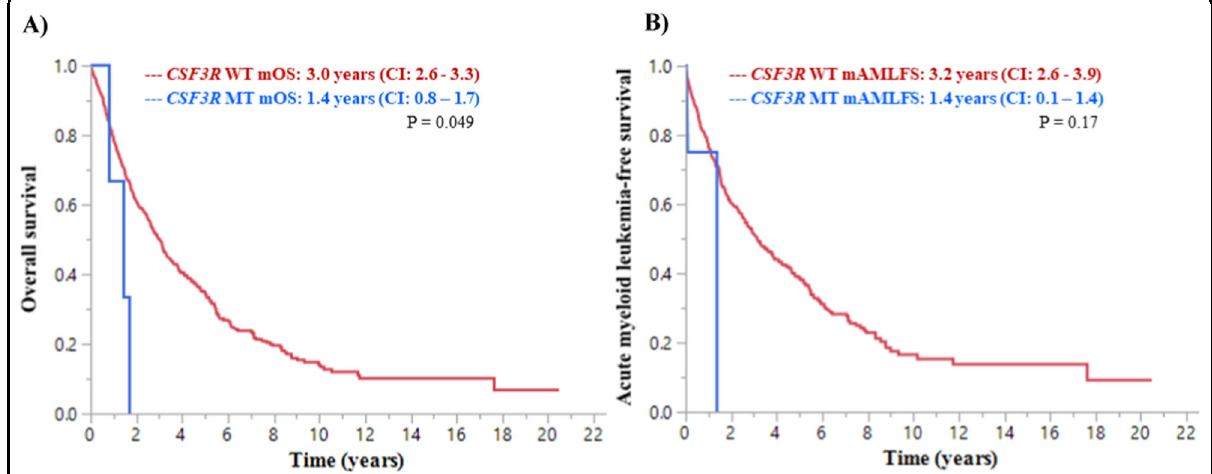
Fig. 1 Kaplan – Meier survival analysis of CMML patients strati fi ed by the presence or absence of the CSF3R T618I mutation. A Inferior overall survival of CSF3R T618I mutant CMML in comparison to CSF3R wildtype patients. B Inferior acute myeloid leukemia-free survival of CSF3R T618I mutant CMML in comparison to CSF3R wildtype